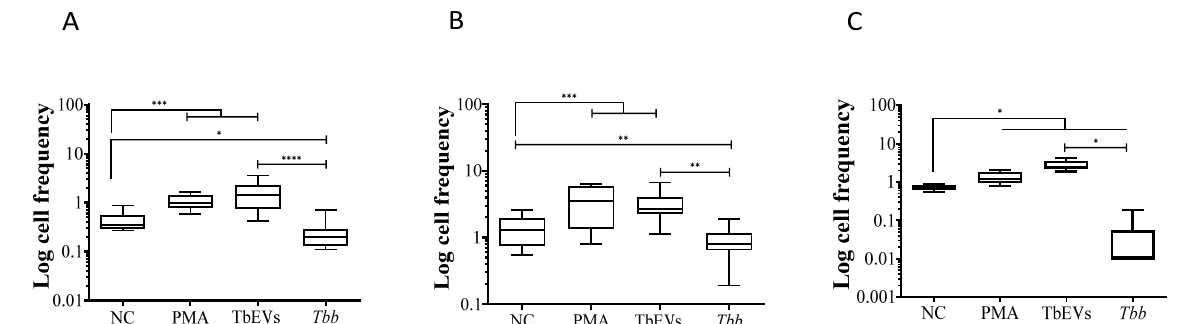
Figure 5. MHCI and MHCII surface expression by M Φ exposed to TbEVs. After 24 h of incubation, the frequency of MHCI + ( A ), MHCII + ( B ), and MHCI + MHCII + cells ( C ) was evaluated in M Φ exposed to T. b. brucei ( Tbb ) parasites, in M Φ stimulated by TbEVs and PMA, and in resting-M Φ (negative control, NC). Results of at least three independent experiments ( n = 32) and at two replicates per sample are represented by whisker box-plot, median, minimum, and maximum values. The non-parametric Wilcoxon matched-pairs signed-rank test was used for statistical comparisons. * ( p < 0.05), ** ( p < 0.01), *** ( p < 0.001), and **** ( p < 0.0001) indicate statistically significant values.